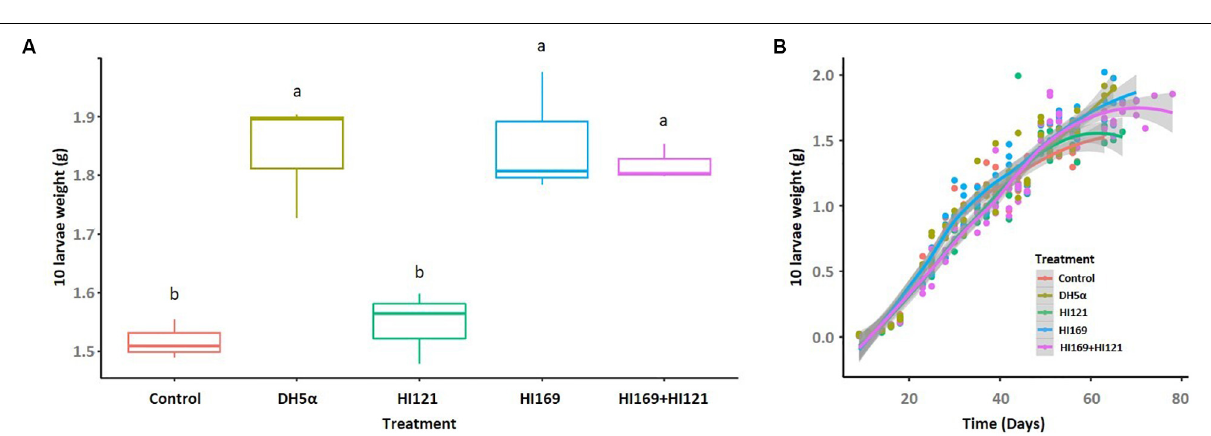
FIGURE 3 | Larval final weight and growth rate following the bacterial administration. (A) Final weight of 10 larvae, reported in grams, are shown for the different treatments. (B) Growth rate of 10 BSF larvae reared on non-sterile fruit-based diet with or without the selected bacterial strains. The horizontal axis indicates the time (days), while the vertical axis reports the weight of 10 larvae (grams). Control: non-sterile diet without any selected strains; DH5 α : larvae fed with the outsider strain of E. coli DH5 α pKan(DsRed); HI121: larvae added with S. maltophilia strain HI121; HI169: larvae supplemented with B. licheniformis strain HI169; HI169 + HI121 larvae fed with the two selected